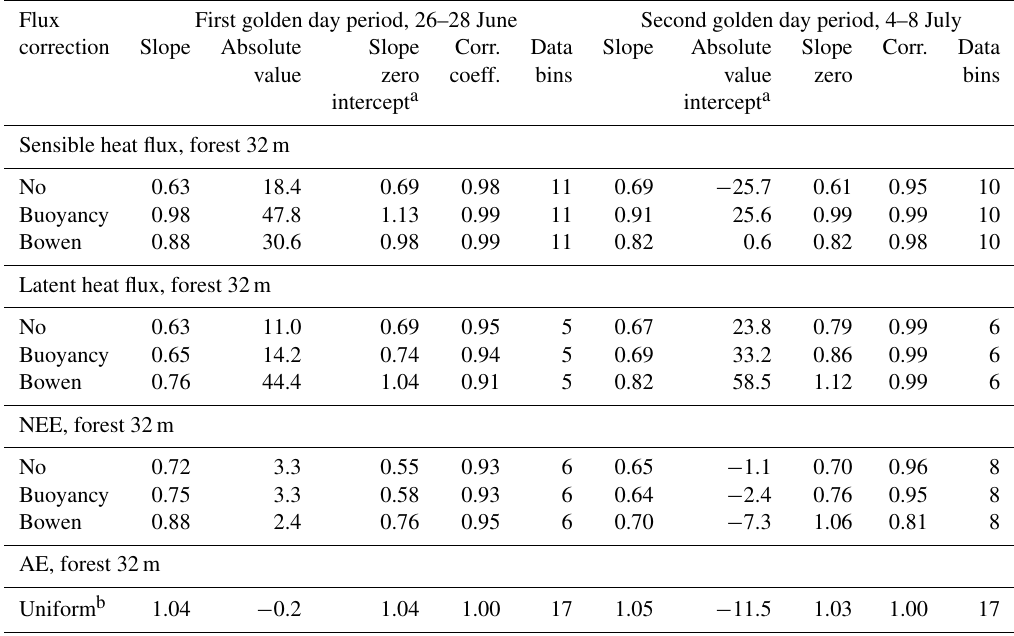
Table 4. Results of the comparison of the measured and the modeled flux data for different correction methods with an orthogonal regression for binned data points for the forest (absolute values in Wm − 2 or µmolm − 2 s − 1 for the NEE).